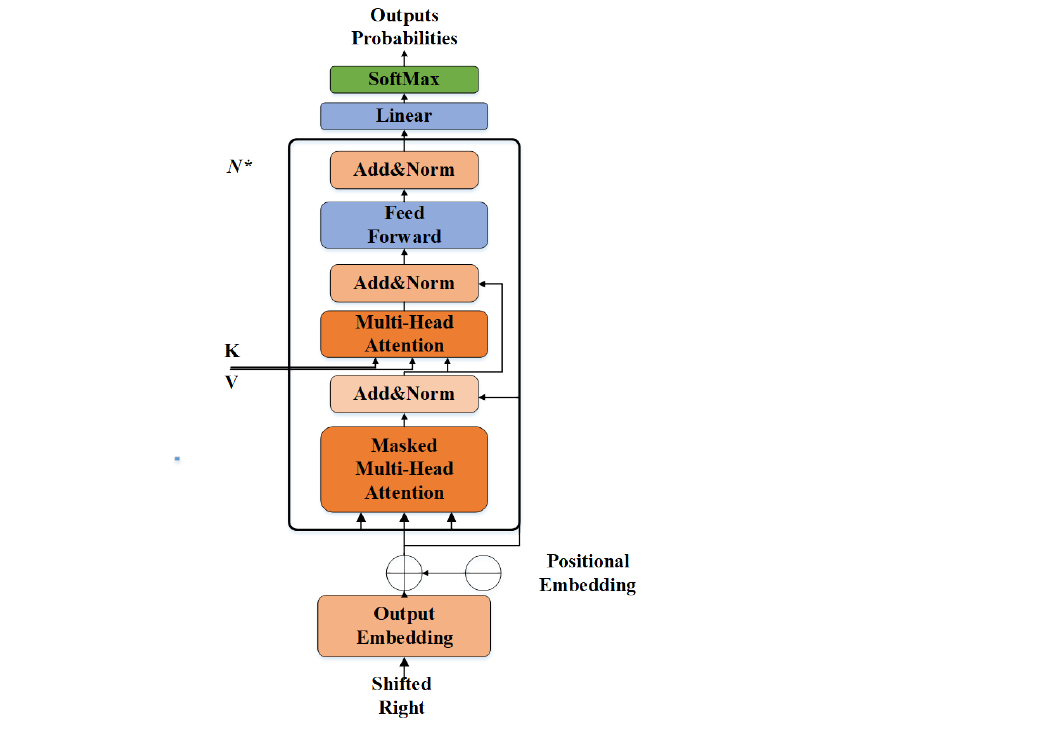
Figure 6. Decoder architecture